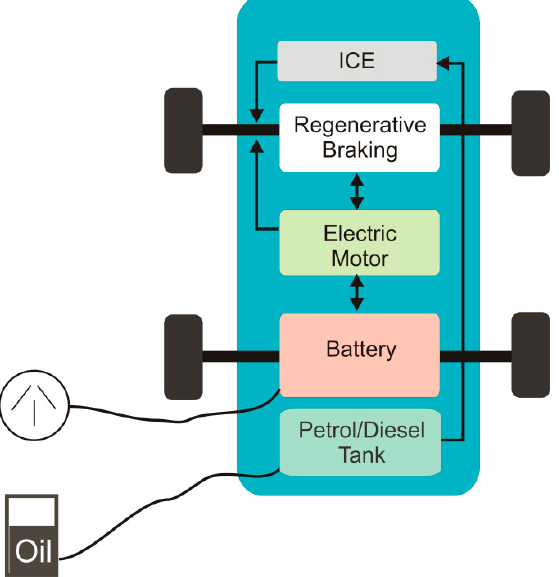
Figure 6. Architectural diagram of plug-in hybrid electric vehicles (PHEVs).